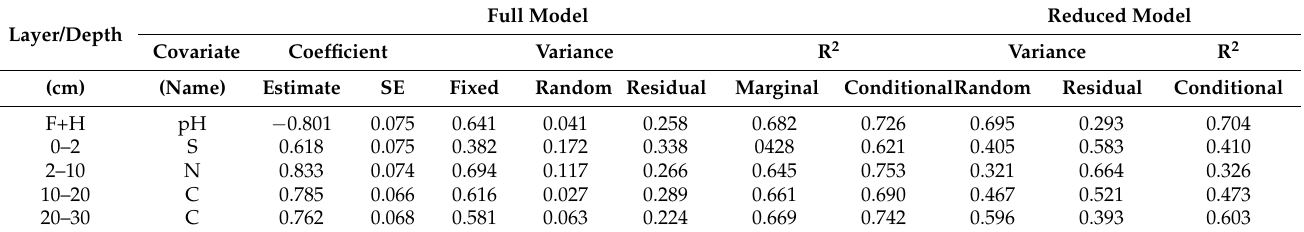
Table 2. The best mixed effects models of Hg contents with selected independent soil variables (covariates) as fixed effects; all fixed effects were significant at p < 0.001 based on the likelihood-ratio test. Random effects were represented by the factor site. In the “full model”, the fixed effects were represented by soil covariate; in the “reduced model”, the fixed effects were replaced by a constant. For each soil layer, fixed effect coefficients, the variance corresponding to fixed and random effects, and the proportion of variance explained by fixed effects (marginal R 2 ) and by the whole model (conditional R 2 ) are provided.